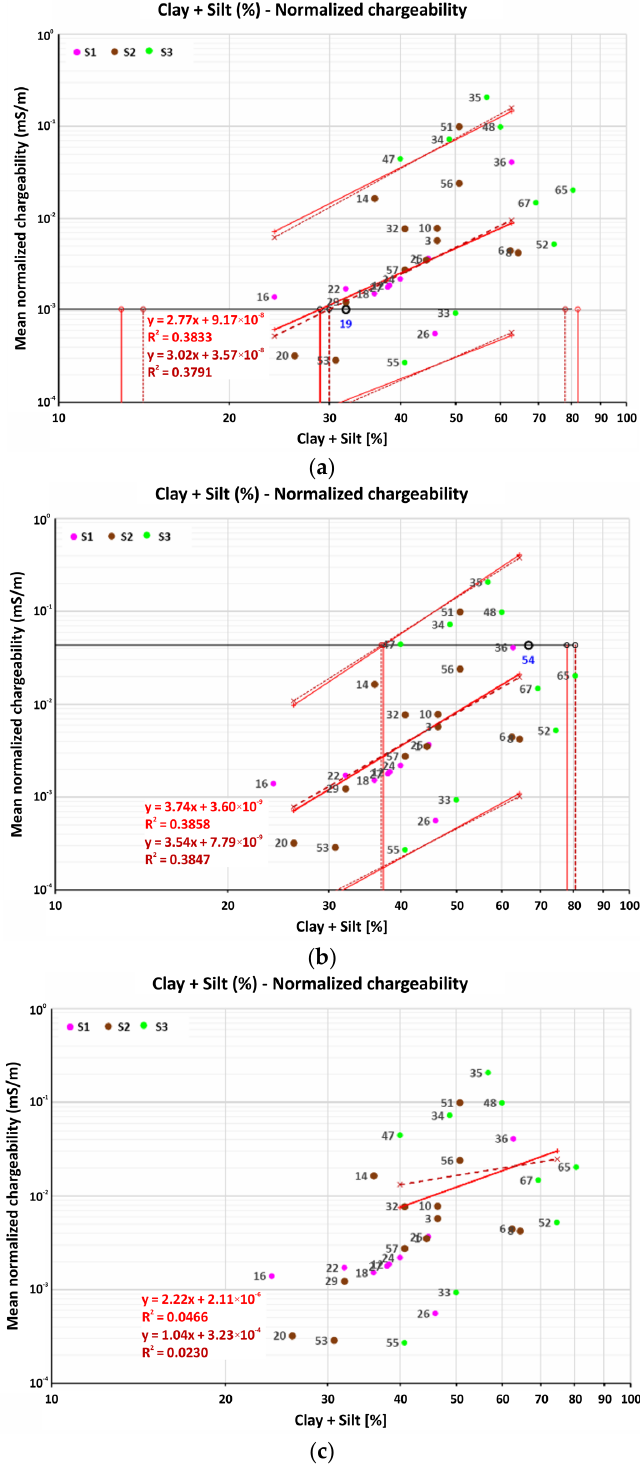
Figure 8. Sum of clay and silt (%) versus M n (mS/m) log–log diagrams with the data from the 33 sites surveyed during the dry period. Red solid and dark red dashed slanted lines correspond to the OLS and WLS linear regression, respectively. ( a ) The evaluation of the sum of clay and silt content (vertical solid and dashed lines) from the M n value for site #19 (black circle) of the S1 dataset and ( b ) the evaluation of the sum of clay and silt content (vertical solid and dashed lines) from the M n value for site #54 (black circle) of the S2 dataset. ( c ) The corresponding linear regression for the S3 subset. No clay and silt content evaluation was performed due to a poor data